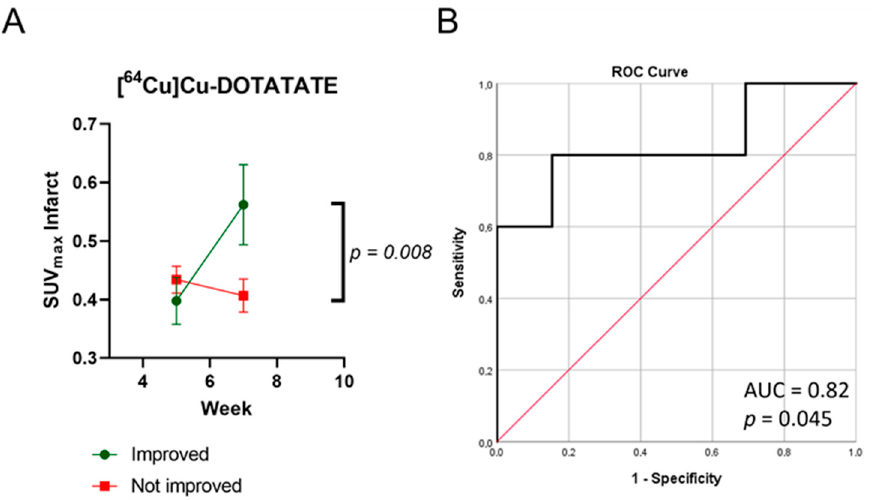
Figure 5. Differences in uptake of [ 64 Cu]Cu-DOTATATE between animals that improved LVEF and those that did not ( A ). ROC analysis for predicting LVEF based on [ 64 Cu]Cu-DOTATATE uptake with SUV max at week 7 (one week after treatment) ( B ), n = 17.